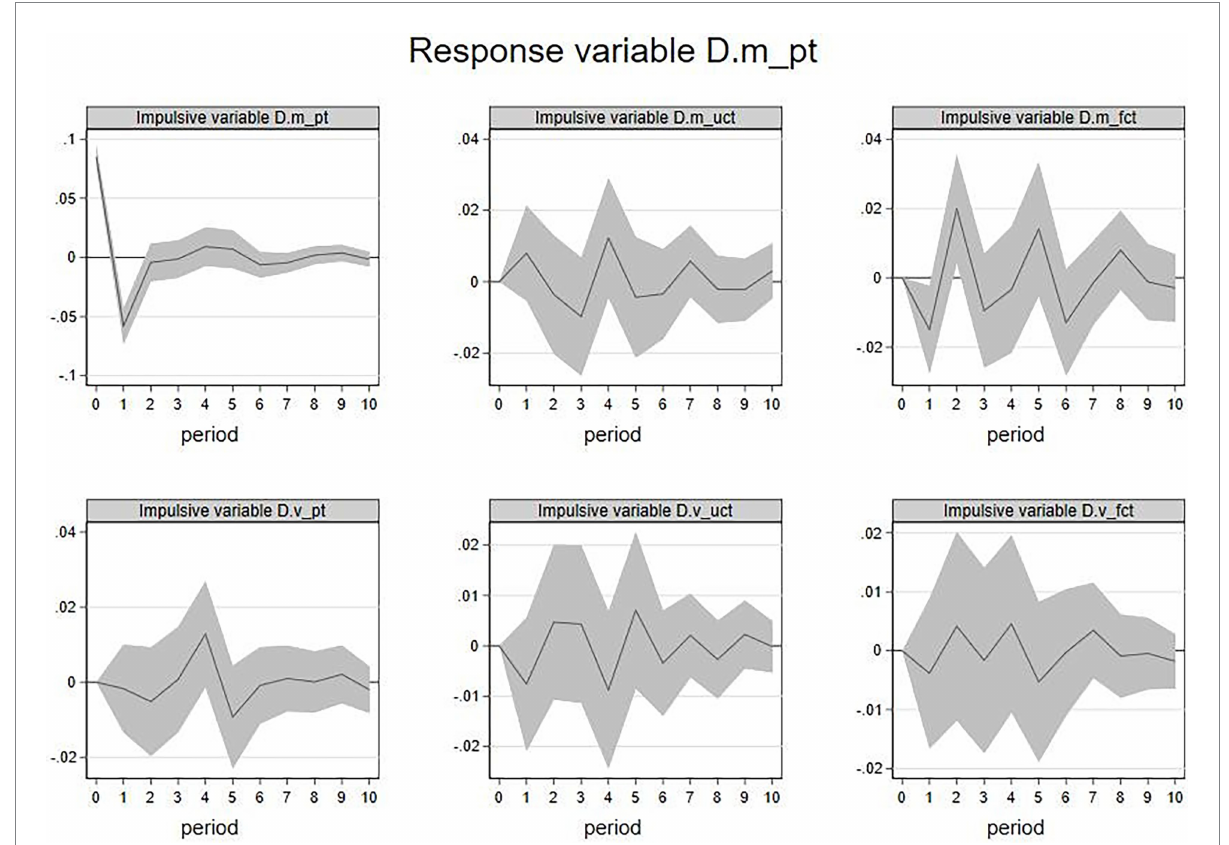
FIGURE 2 IRF: _ D.m pt (response variable). Shadow represents 95% confidence interval. 2. X-axis represents period(s), and Y-axis represents the variation of the response variable. 3. The impulsive variable can be seen in the gray part at the top of each image. The same is